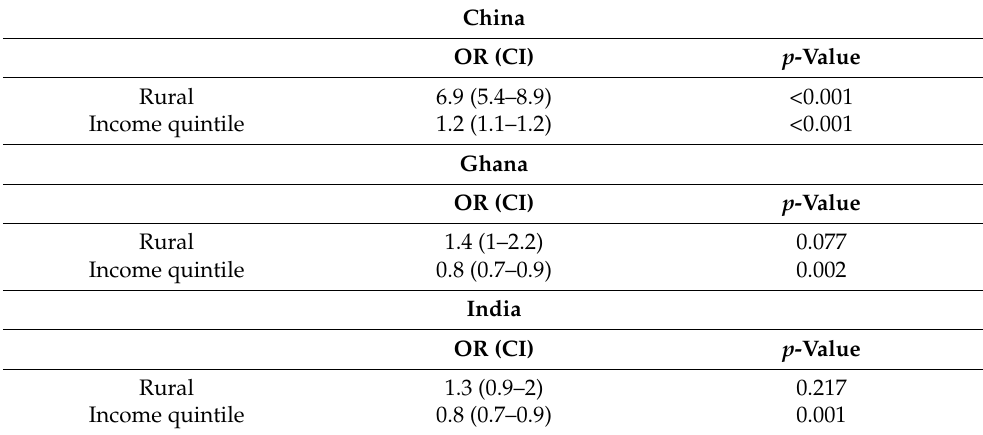
Table 3. Adjusted odds ratios and 95% confidence intervals of users of traditional healers by demographics in China, Ghana, and India. Adapted with permission from Ref. [165]. Copyright 2016,